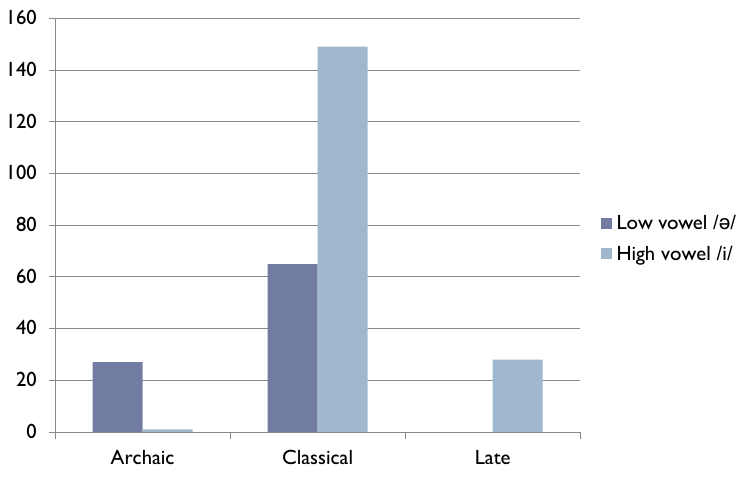
Figure 1: Attestations of raised TB ñiś and non-raised TB ñǝś according to chronological stage (absolute